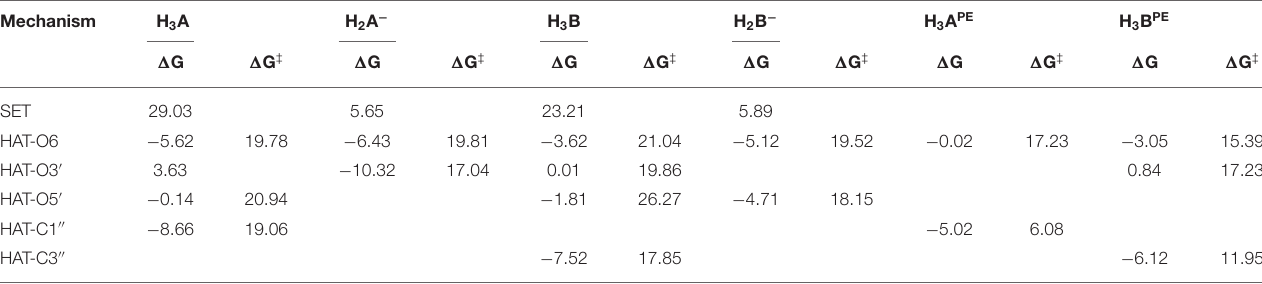
TABLE 2 | Gibbs free energies of reaction ( 1 G) and activation ( 1 G ‡ kcal/mol) at 298.15K in aqueous solution for neutral and monoanion moracin C and iso -moracin C species for the considered mechanisms.